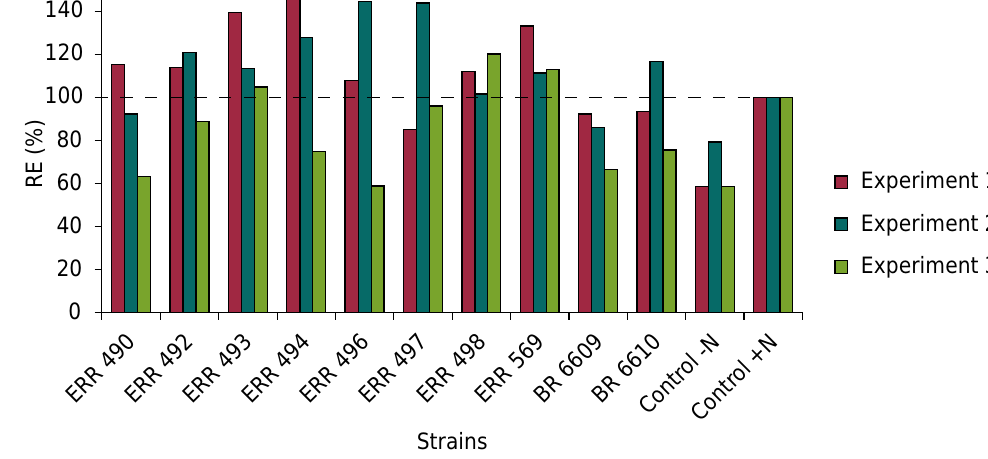
Figure 2. Relative effectiveness of Bradyrhizobium ingae strains inoculated in Inga edulis Mart. plants. Experiment 1 - sterile substrate in a greenhouse; Experiment 2 - non-sterile soil in a greenhouse; and Experiment 3 - non-sterile substrate in a nursery.